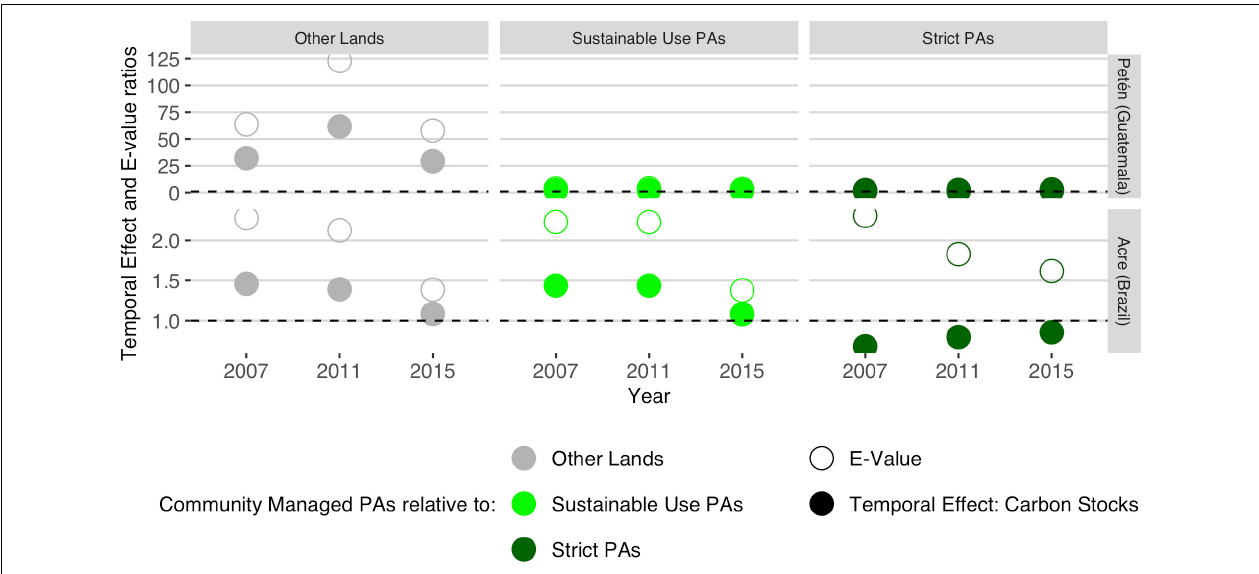
FIGURE 4 | Sensitivity analysis in the temporal effects of Community Managed PAs on carbon stocks in Petén (Guatemala) and Acre (Brazil). The temporal effect ratio (unitless) is equivalent to the probability of a positive temporal effect in the treatment (i.e., Community Managed PAs) divided by the probability of a positive temporal effect in the controls (i.e., Other Lands, Sustainable Use PAs, and Strict PAs). The E -value represents the minimum strength that an unmeasured covariate would need to have with the treatment and the temporal effect for the treatments and temporal effect association not to be